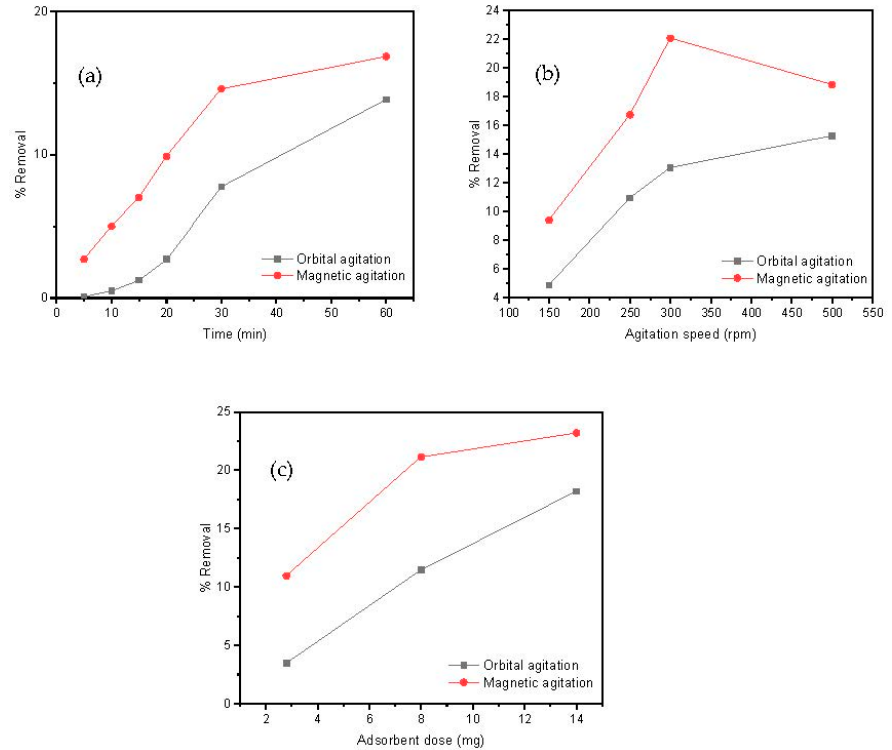
Figure 5. Parameters’ influence on Cd(II) adsorption: ( a ) contacting time, ( b ) agitation speed, and ( c ) adsorbent